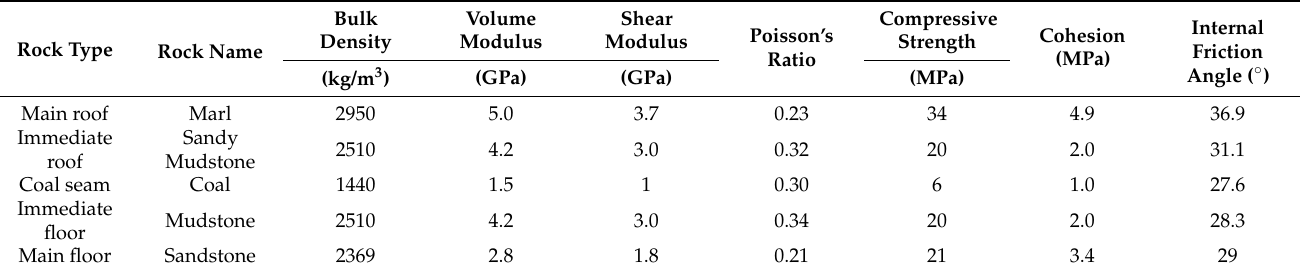
Figure 1. Local filling mining method with artificial gangue. As shown in this figure, the grey blocks represent goaf, the green and black blocks represent collapse roof, and the gray-black blocks represent the local filling of artificial gangue. Table 1. Mechanical parameters of coal and rock.